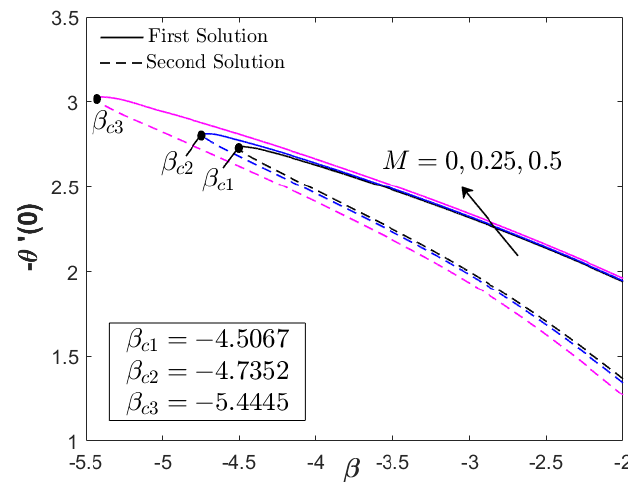
Figure 3. − θ (cid:48) ( 0 ) for various M (magnetic parameter). ( ) 0 θ ′− for various M (magnetic parameter). Figure 3. ( ) 0 θ ′− for various M (magnetic parameter). Figure 3.